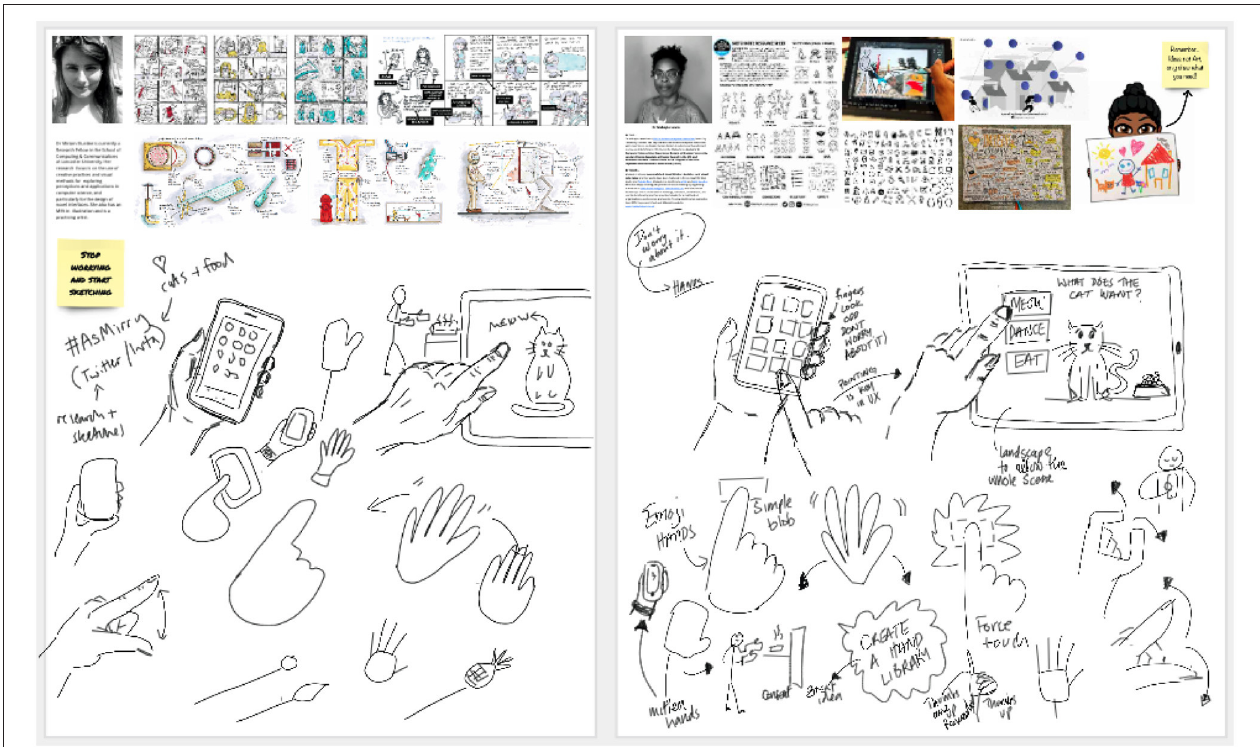
FIGURE 8 | Example interactive Miro board for demonstration of sketching devices, interactions, and gestures for storytelling and storyboarding lecture with a guest speaker. Makayla Lewis and Miriam Sturdee, 2021.